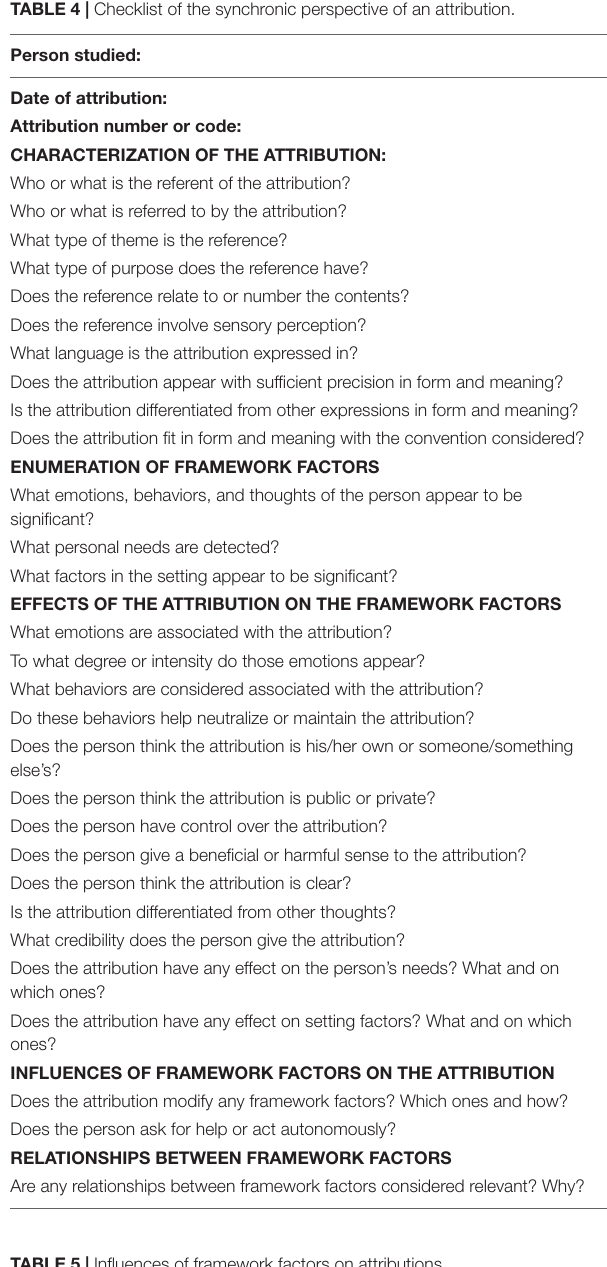
TABLE 5 | Influences of framework factors on attributions.